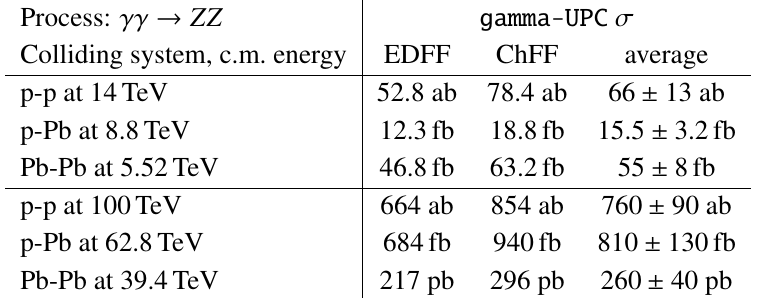
Table 9 . Total SM cross sections for (cid:13)(cid:13) ! ZZ in UPCs at the LHC and the FCC-hh, computed with EDFF and ChFF (cid:13) fluxes and their